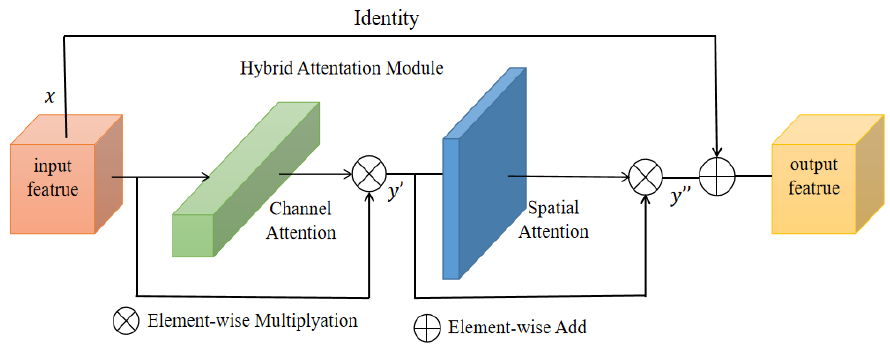
Figure 3. Hybrid residual